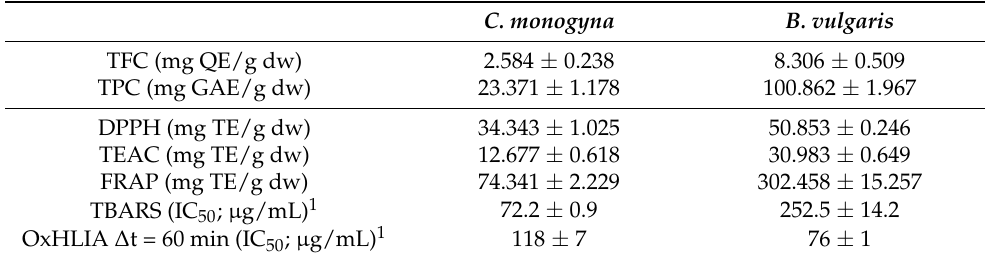
Table 2. Total phenolic content (TPC), total flavonoid content (TFC), and antioxidant activity. C.